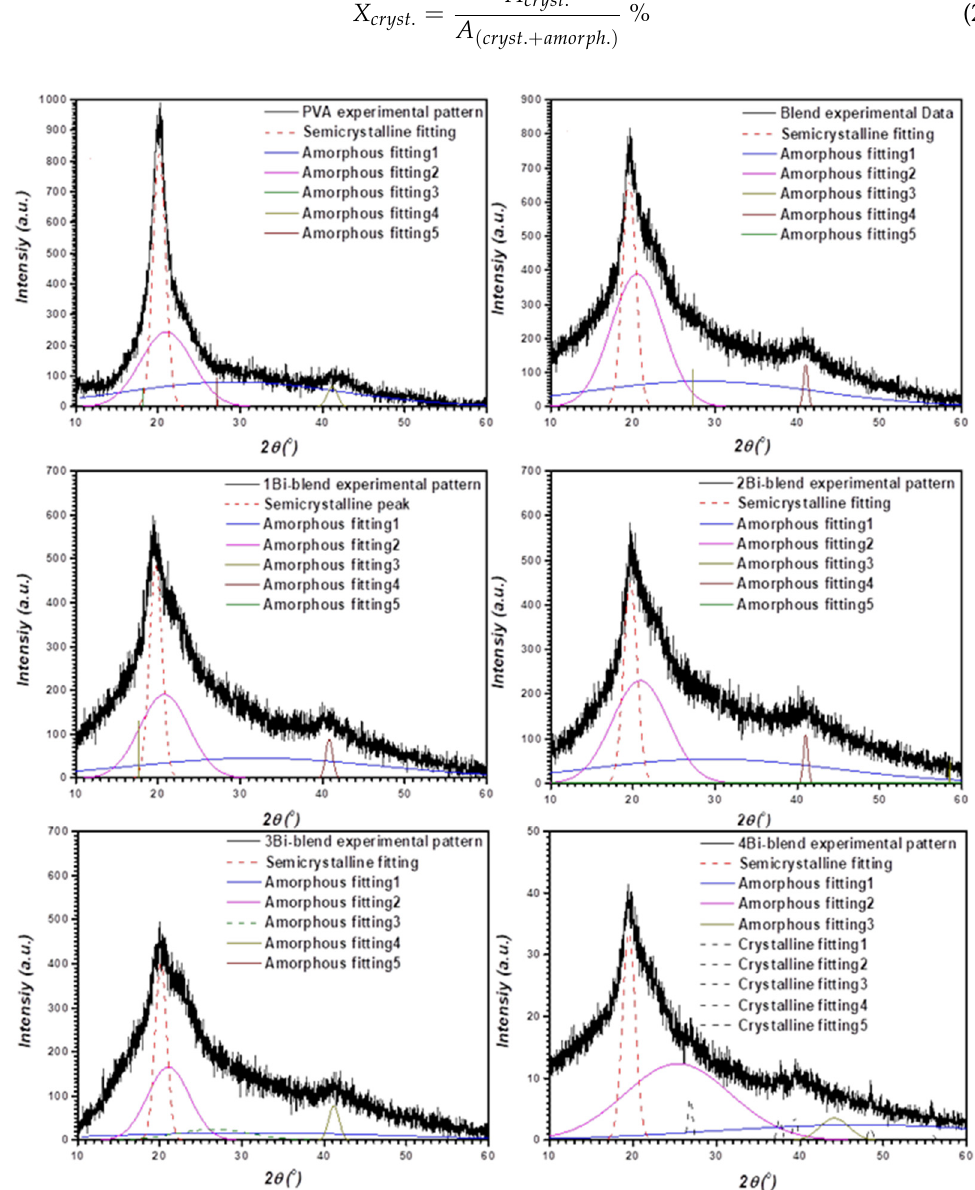
Figure 2. Deconvoluted XRD patterns of pure and composite films.